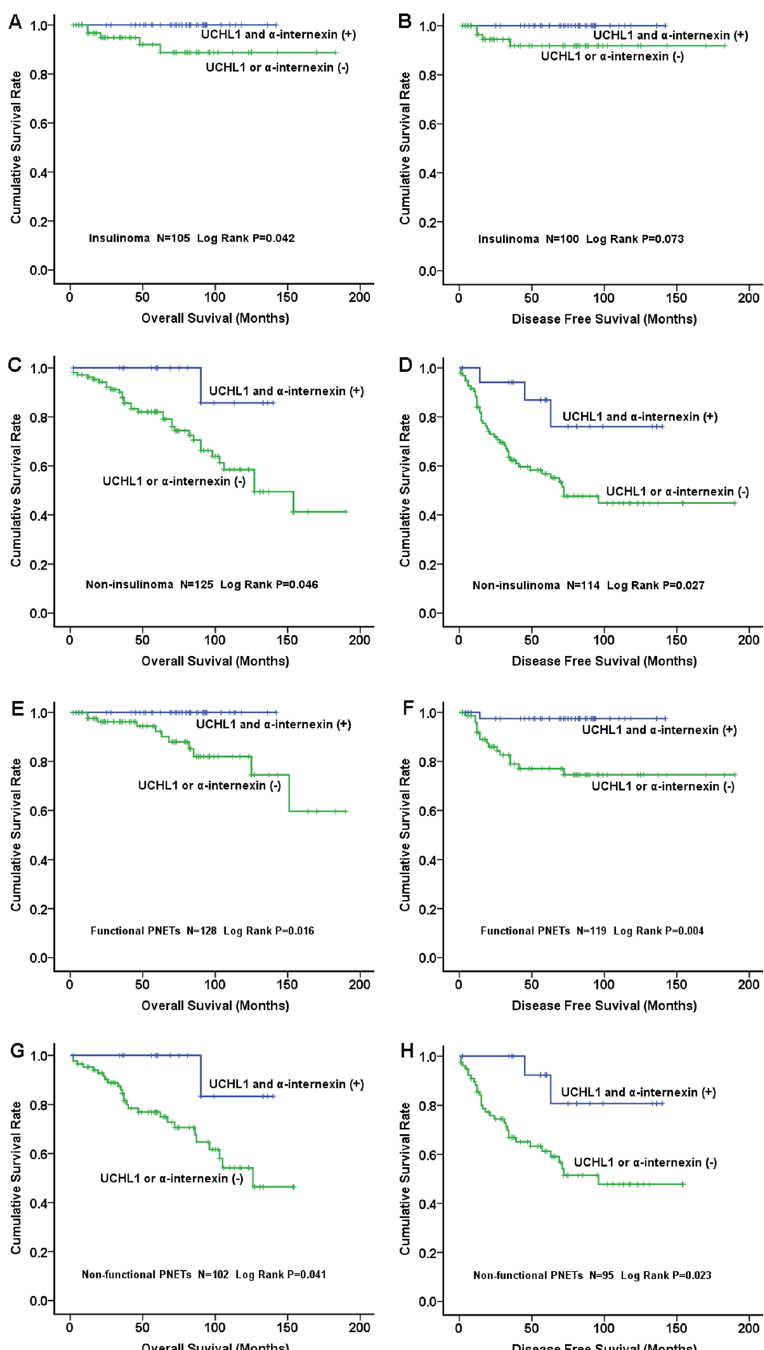
Figure 5. Correlation of Concurrent Expression of UCH-L1 and α -internexin with Prognosis in Subgroups of PNETs. Left panel: overall survival; right panel: disease-free survival. The simultaneous expression of UCH-L1 and α -internexin was correlated with better overall survival and disease-free survival in either insulinomas (Fig. 5A and B, respectively) or non-insulinomas (Fig. 5C and D, respectively). Similarly, the concurrent expression of both proteins was significantly associated with favourable overall survival and disease-free survival in either functional PNETs (Fig. 5E and F, respectively) or NF (Fig. 5G and H,